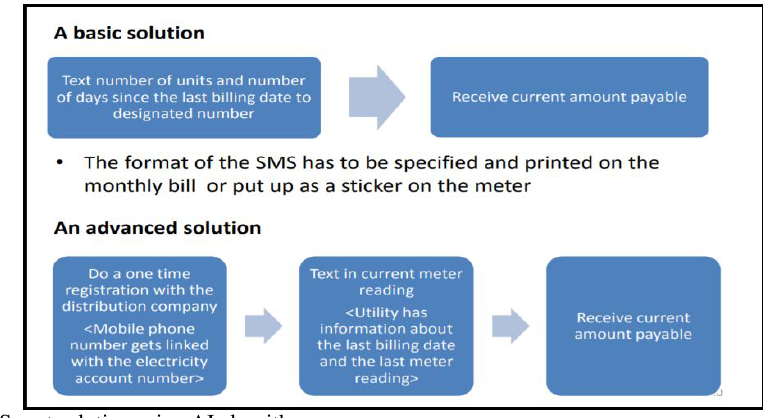
Fig. 1. Smart solution using AI